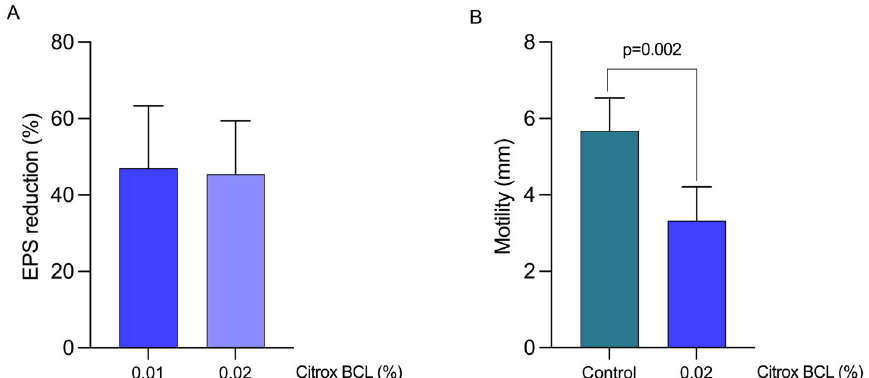
Figure 4. Determination of EPS inhibition of L. pneumophila after exposure to 0.01–0.02% Citrox BCL for EPS (panel ( A )) and 0.02% Citrox BCL for motility (panel ( B )). Each point represents the mean ± standard deviation. The EPS results are expressed as percentage of the control.